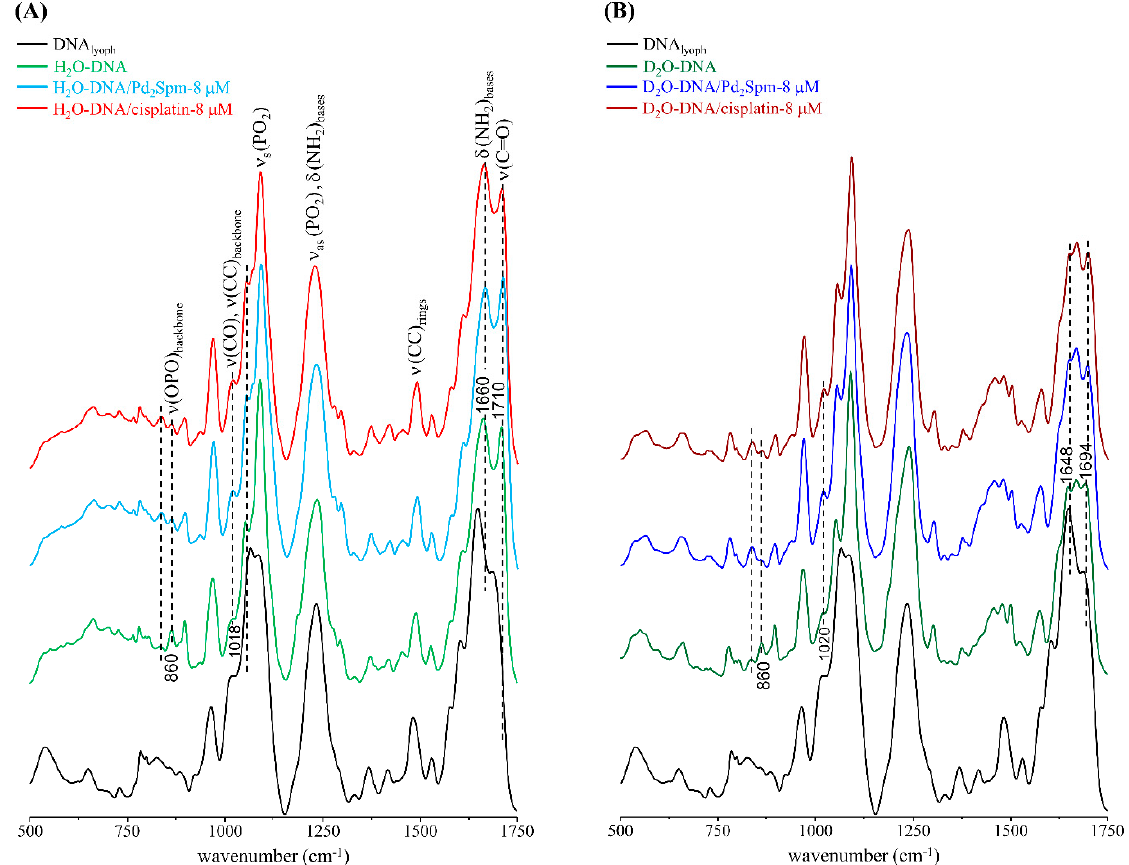
Figure 1. FTIR-ATR spectra (500–1750 cm − 1 ) of DNA lyoph , H 2 O-DNA hyd ( A ) and D 2 O-DNA hyd ( B ), untreated and upon incubation (for 48 h) with cisplatin-8 µ M or Pd 2 Spm-8 µ M. (The main spectral changes are marked by dotted lines).